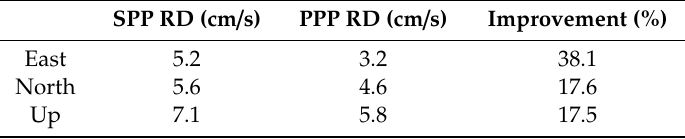
Figure 8. Number of observed satellites of air–borne experiment. Table 5. RMS statistics and comparison of air–borne